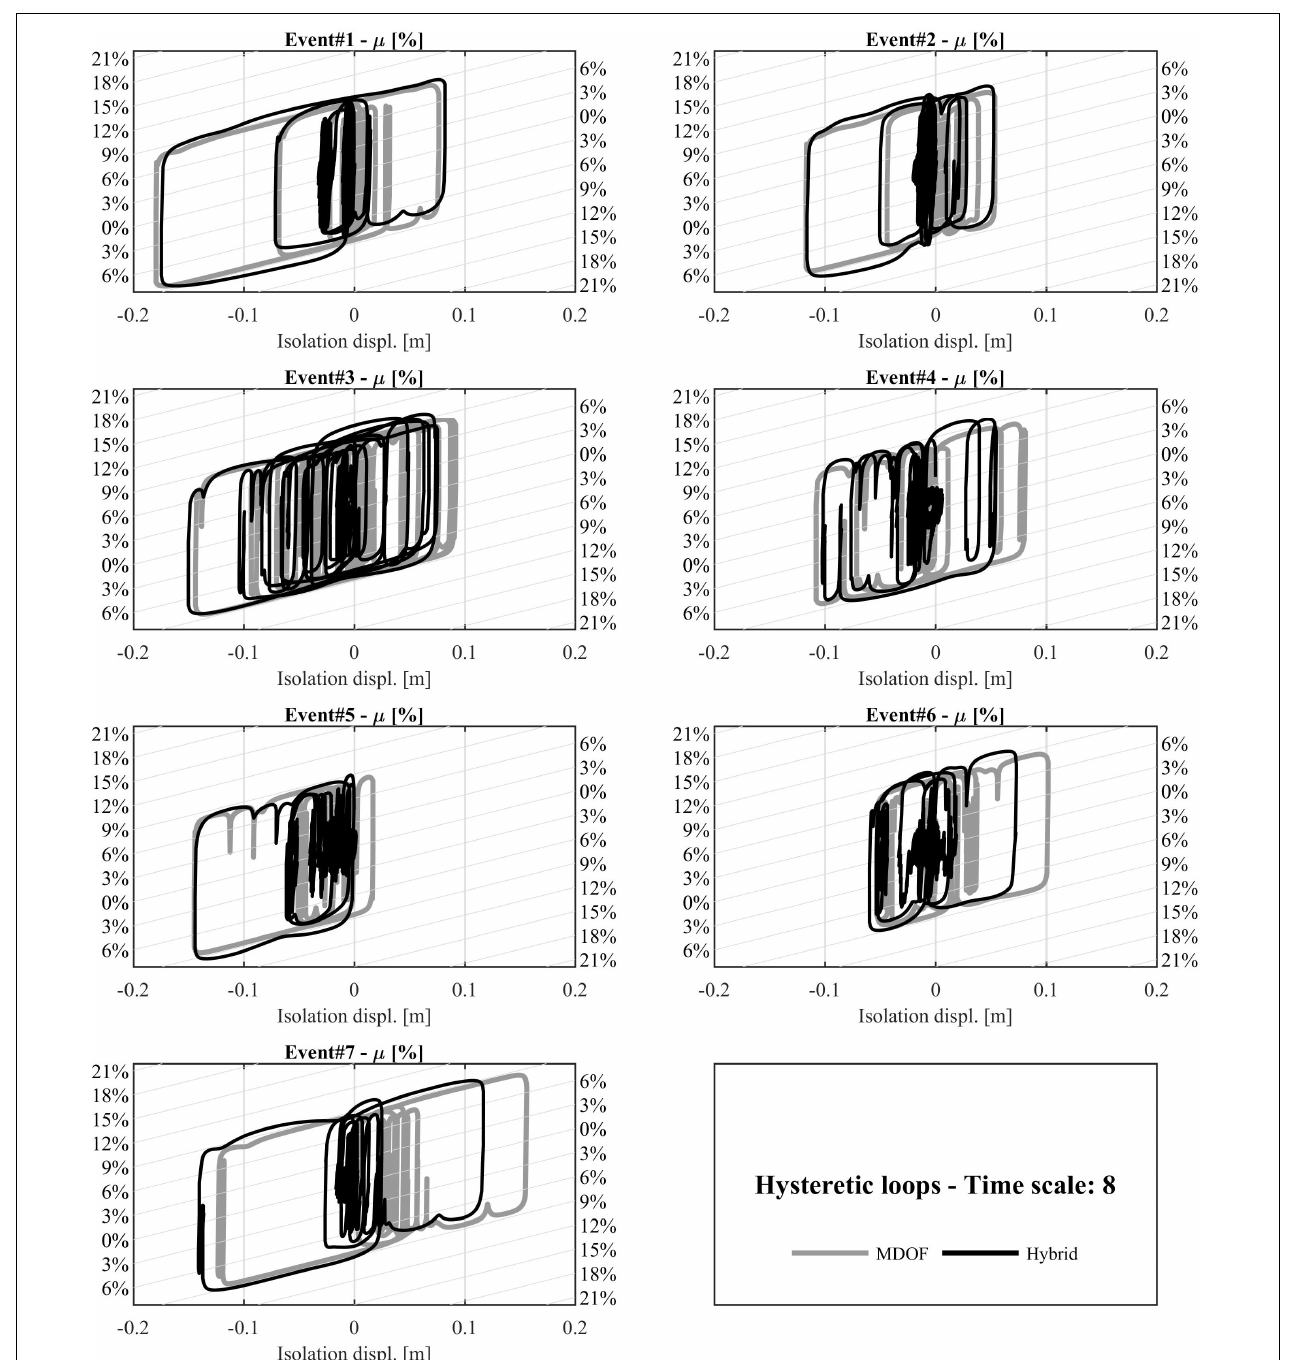
FIGURE 8 | Hysteretic response comparison—time scale 8.